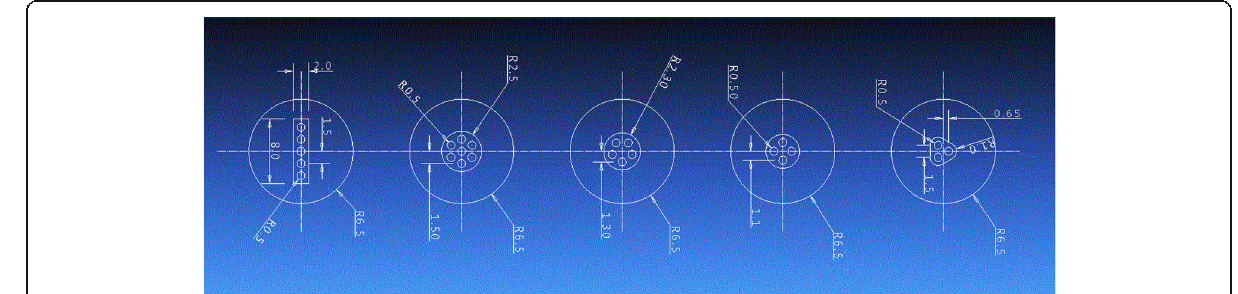
Fig. 2 Detailed nozzle design. All dimensions in millimeters